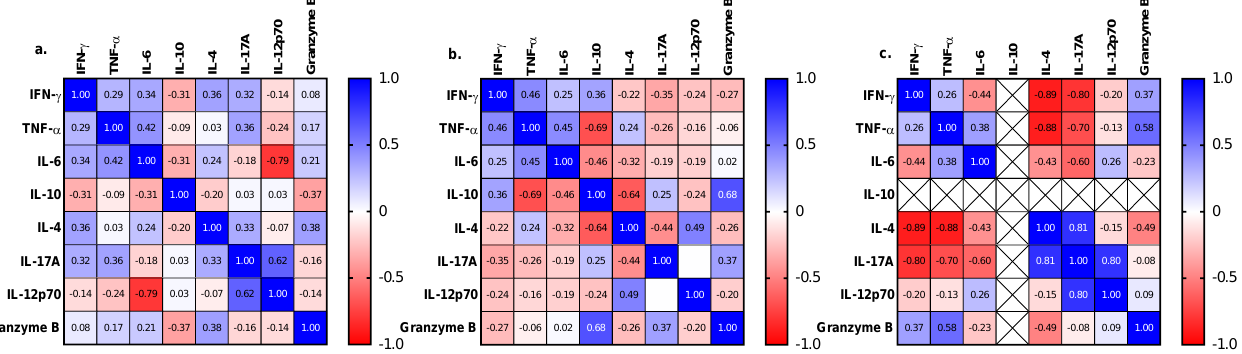
Figure 2. ROC curves ( A – J ) showing the accuracies of individual serum cytokines in distinguishing between No-TB and MDR-TB or DS-TB.